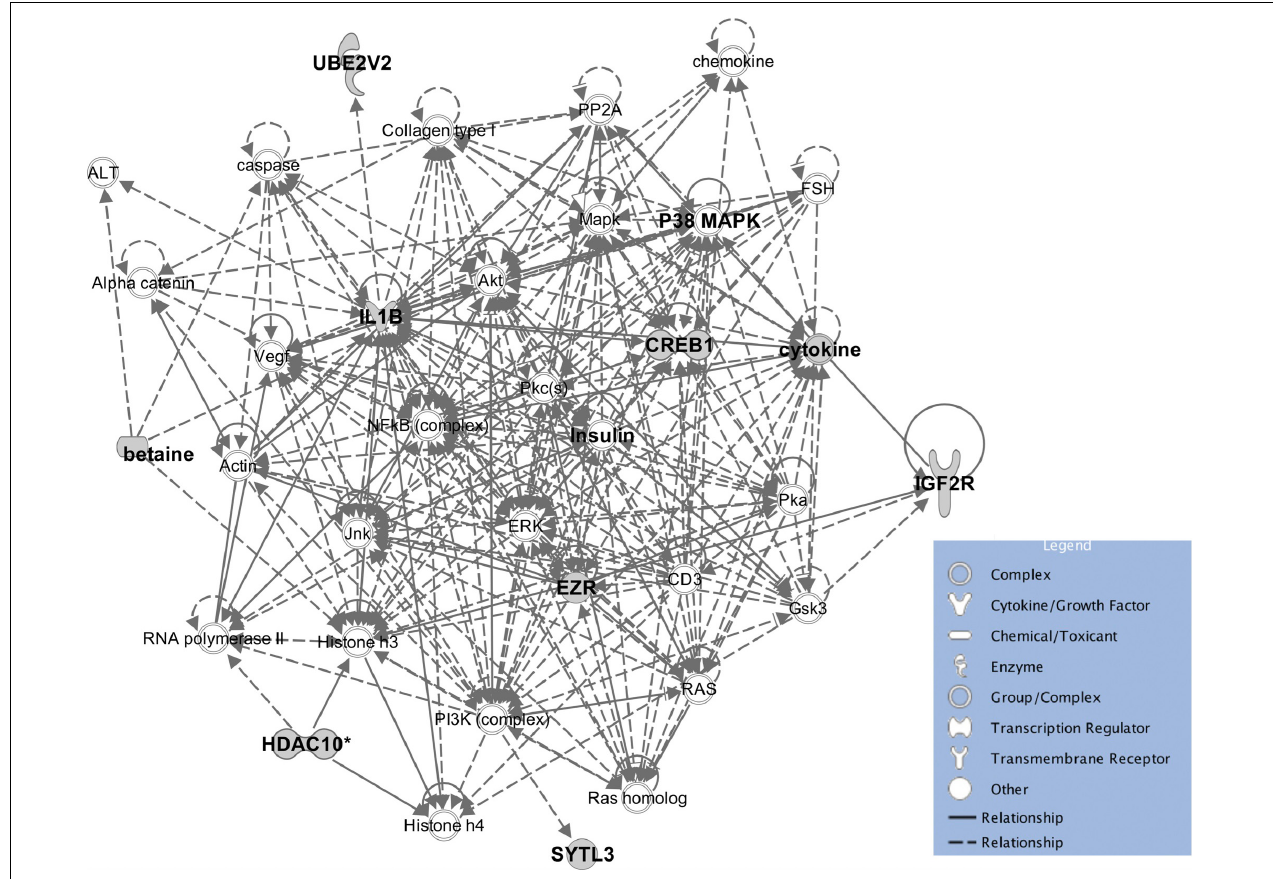
FIGURE 6 | The enrichment network for betaine and associated genes, and the molecules in IPA database. The enriched pathway predicted by IPA showed a potential relationship between betaine, insulin, and